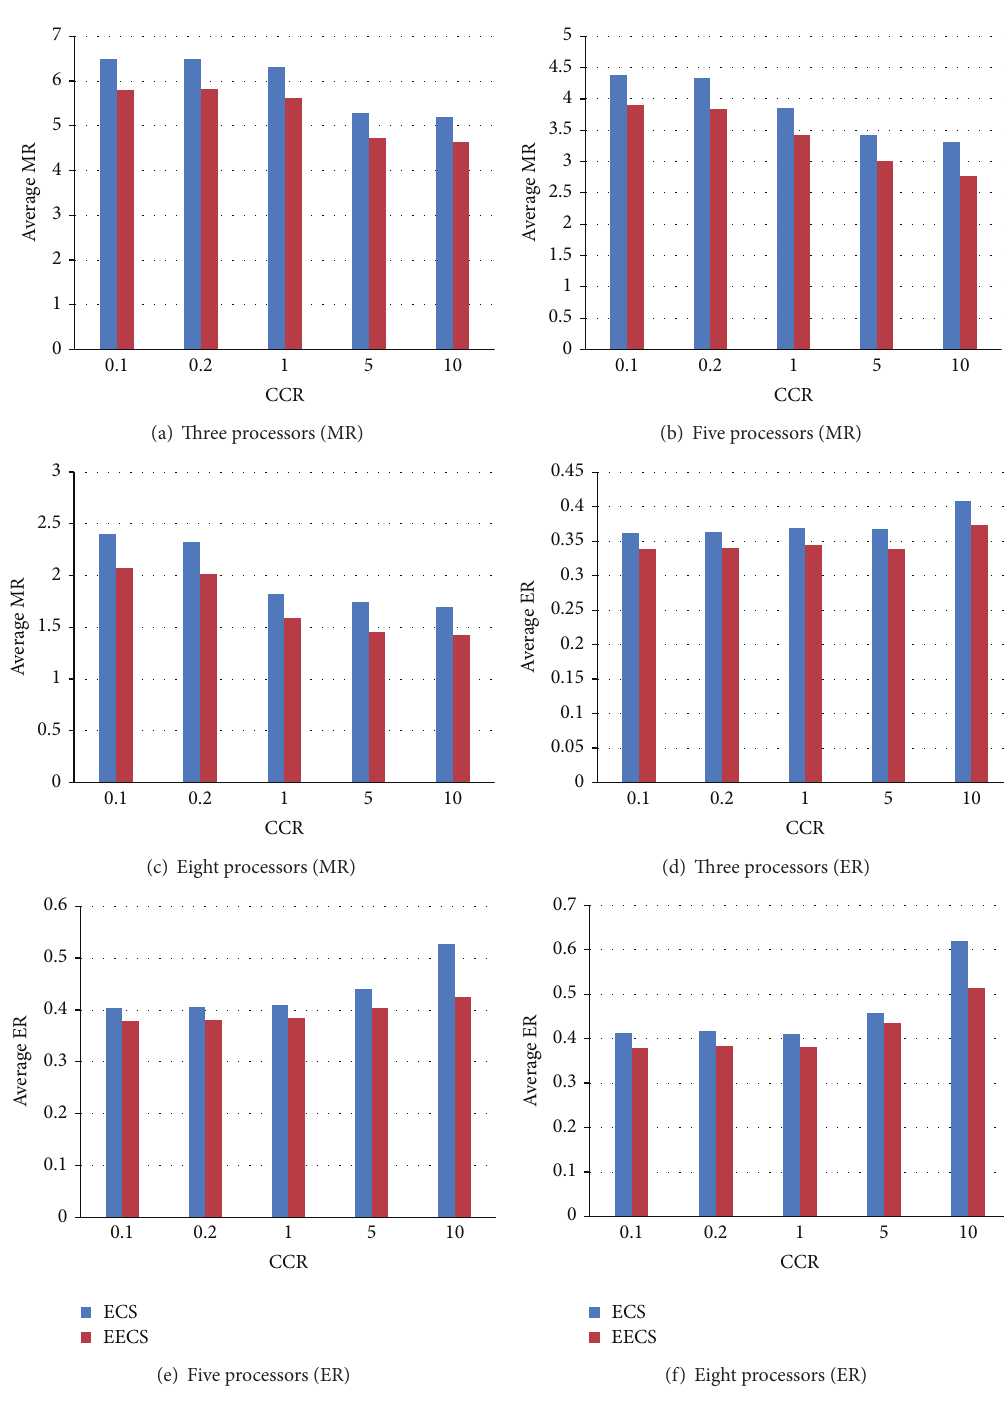
Figure 6: LIGO, 77 nodes (different sizes of